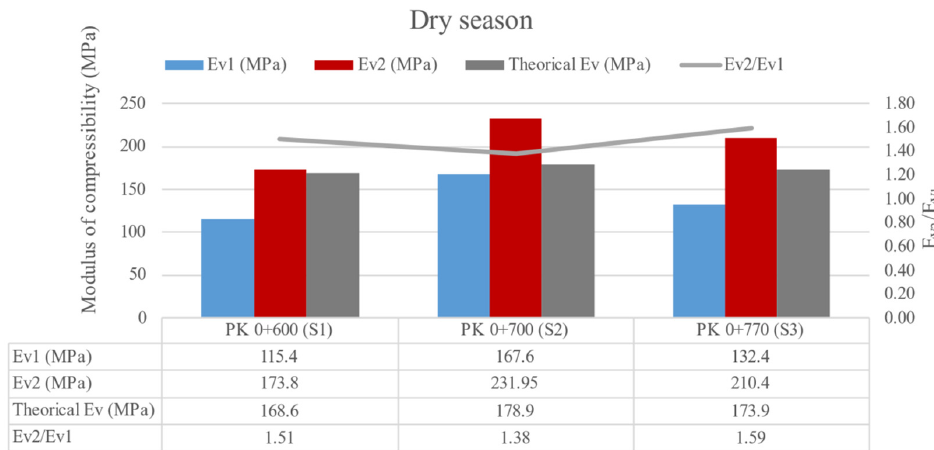
Figure 15. Plate bearing test results in the dry season.